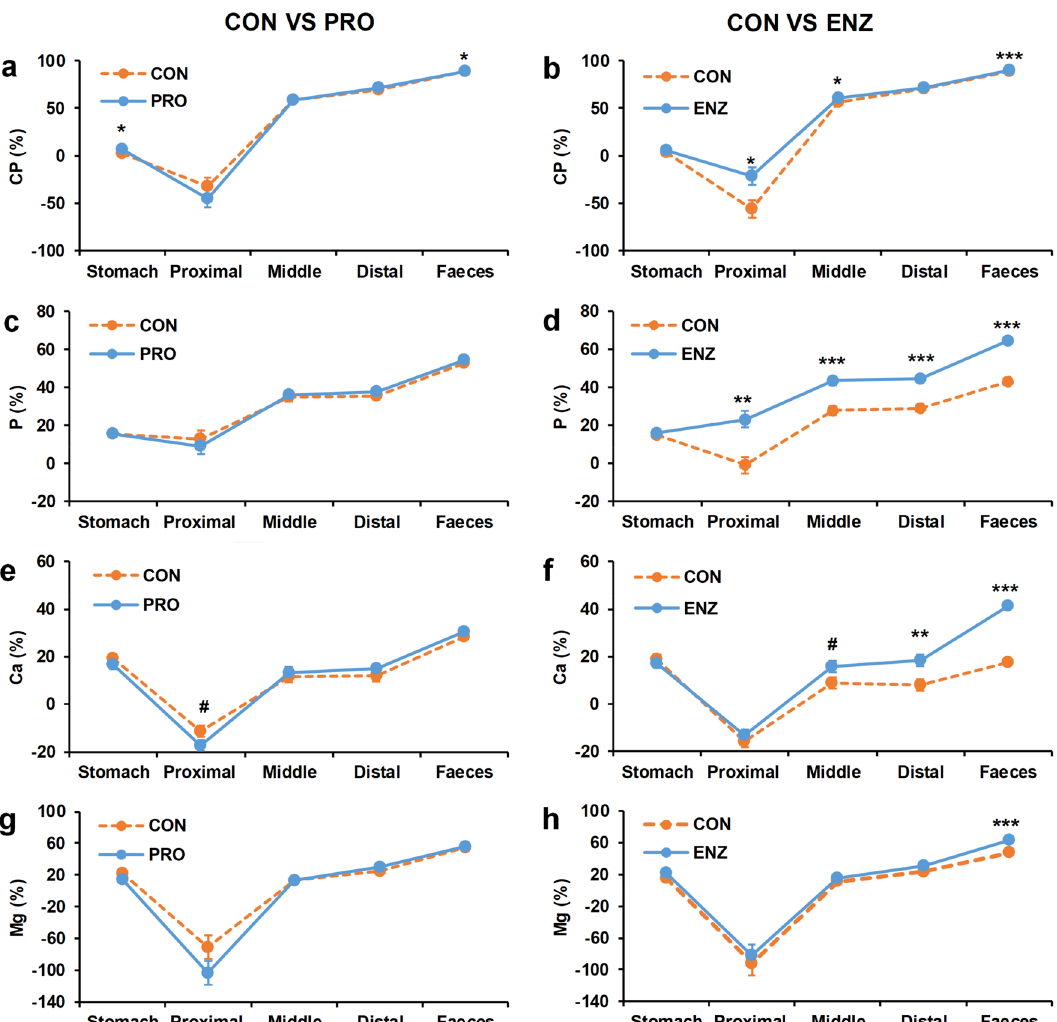
Figure 3. The main effect of probiotic and enzyme supplementation on the kinetics of apparent digestibility coefficient (ADC) in Nile tilapia GIT. The ADC values represent the cumulative ADC from stomach to faeces passing through the proximal, middle and distal gut. The ADC of: crude protein (CP) (panel a , b ); phosphorus (P) (panel c , d ); calcium (Ca) (panel e , f ); and magnesium (Mg) (panel g , h ). In panel a, c, e and g (left side) the main effect of dietary probiotics mixture supplementation on ADC values is shown and in panel b, d, f and h (right side) the main effect of dietary enzyme supplementation on ADC values is shown. The ADC in the stomach, proximal, middle and distal were determined on collected digesta in current study. The faecal ADCs were determined on faeces collected by settling columns during the growth trail (published in 57 ). Error bars indicate standard error of means. CON-PRO, probiotics added; ENZ-CON, enzymes added; ENZ-PRO, enzymes and probiotics added. Symbols: ns, not significant, # P < 0.1, * P < 0.05, ** P < 0.01; *** P <